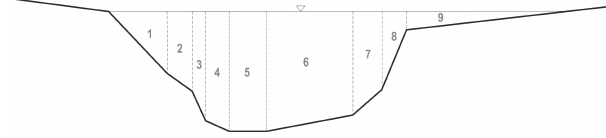
Figure 13. Hunsdorf river cross section: subsections used to com- pute the vertically averaged